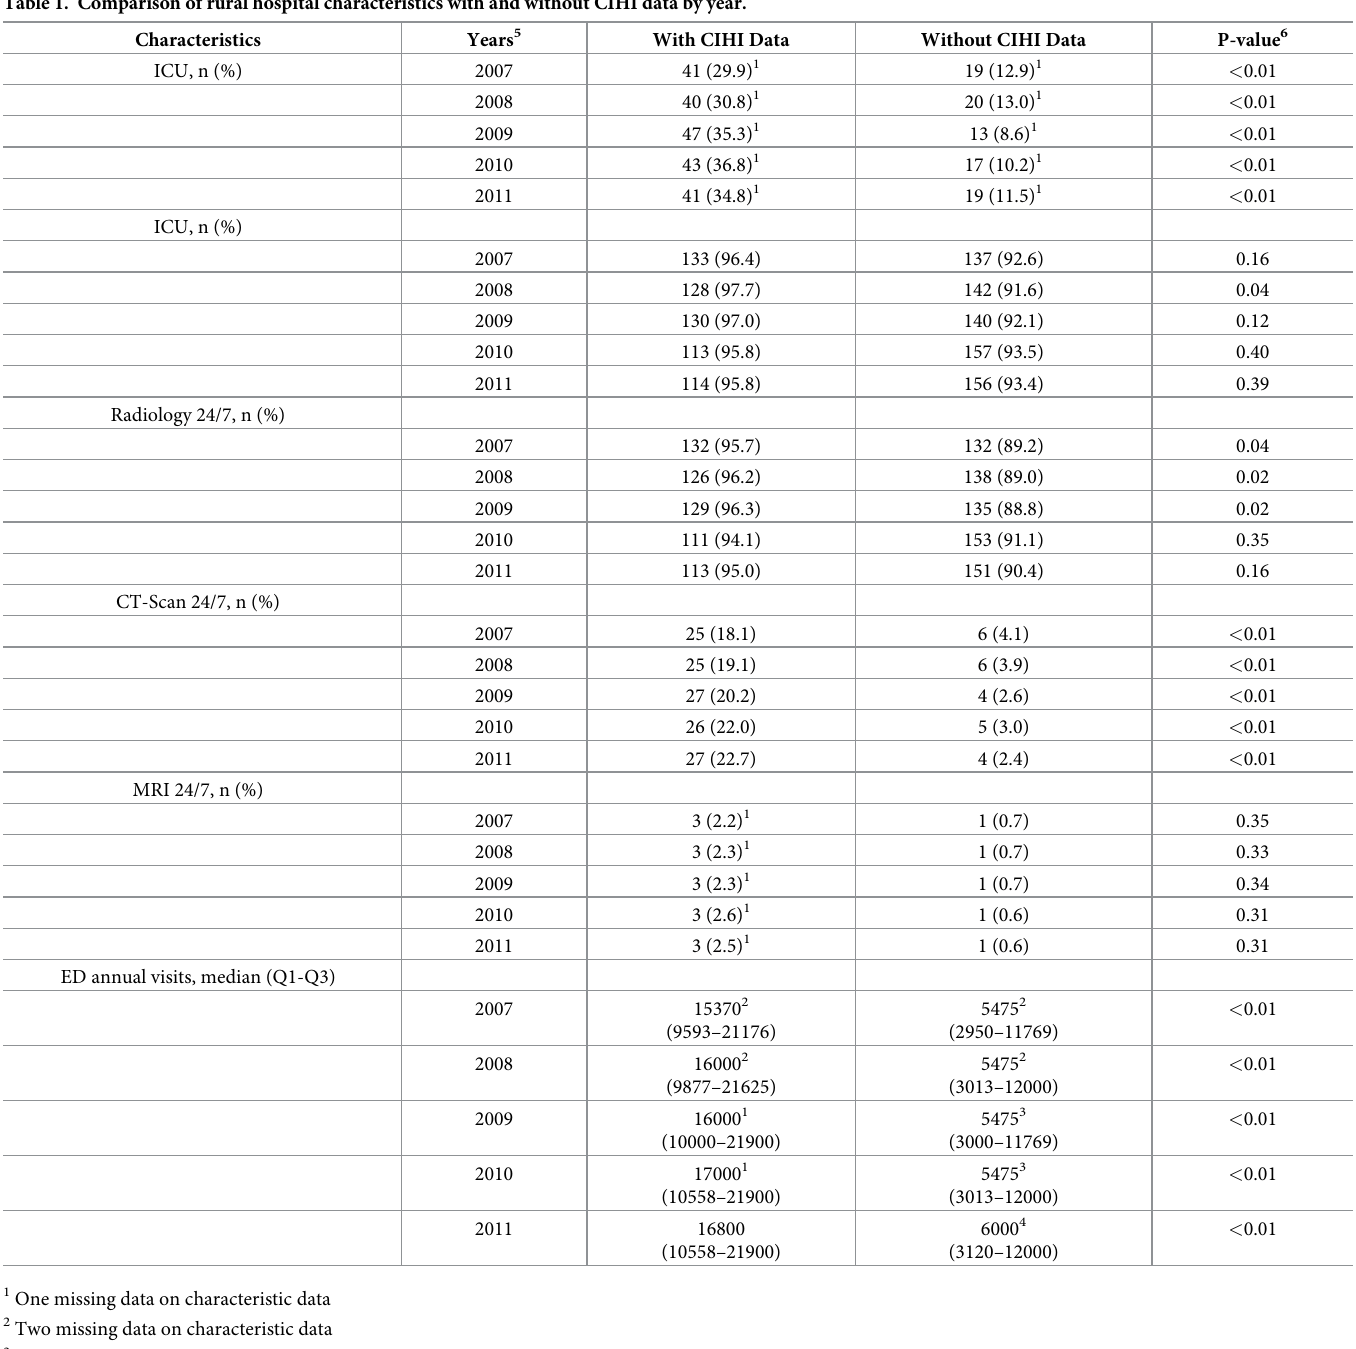
Table 1. Comparison of rural hospital characteristics with and without CIHI data by